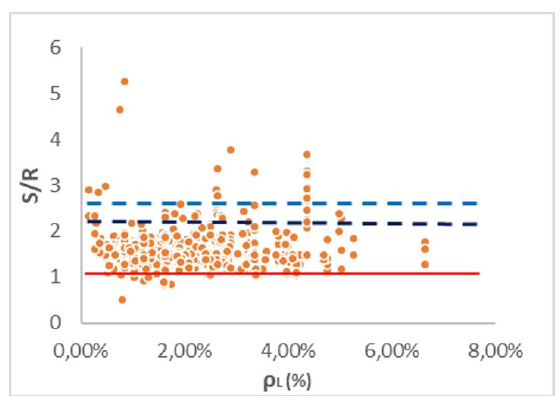
Figure 10- S/R in relation to